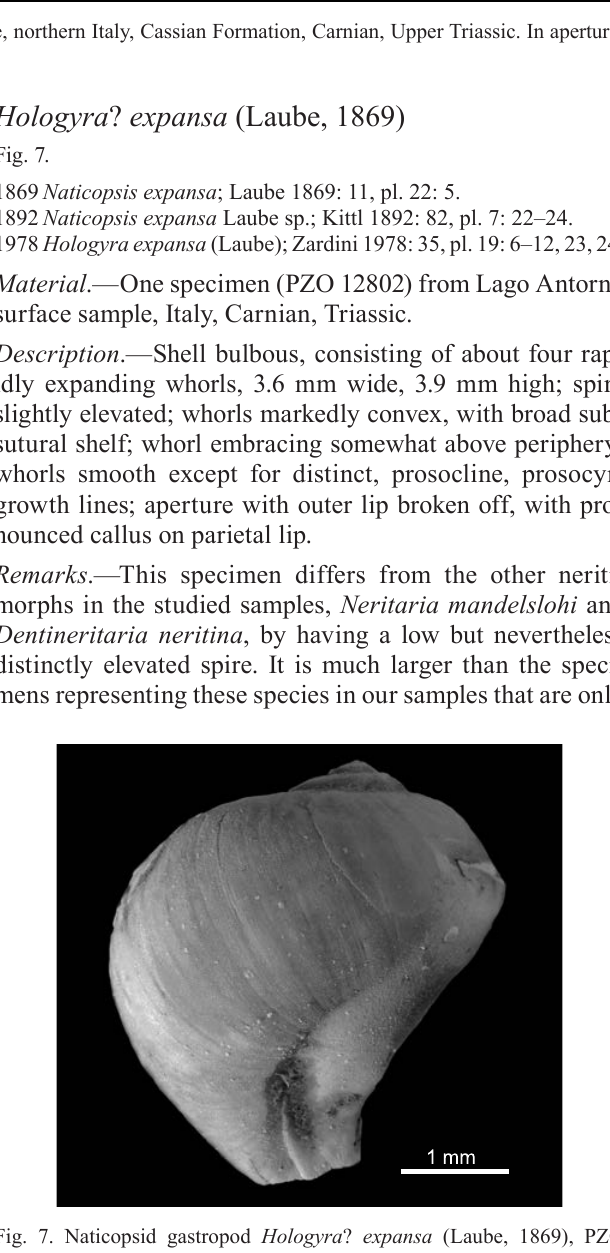
Fig. 7. Naticopsid gastropod Hologyra ? expansa (Laube, 1869), PZO 12802, from Lago Antorno, northern Italy, Cassian Formation, Carnian, Upper Triassic; apertural view showing callus on inner and parietal